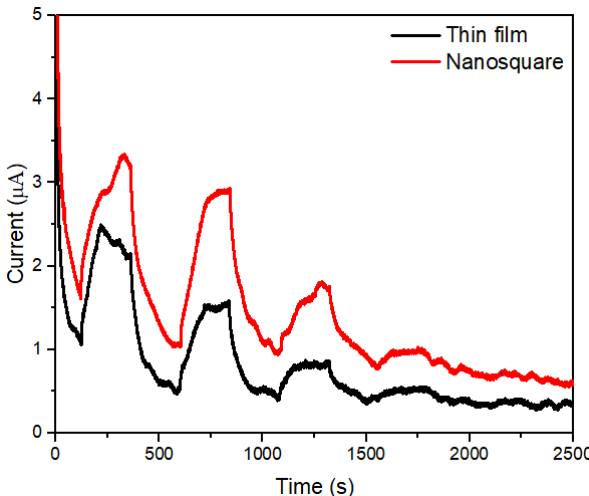
Figure 4. The stability curve of the ZnO/Au thin film and the ZnO/Au nanosquare arrays at scan rates between 0.12 V s -1 and 0.18 mM of glucose concentration under a 450 nm wavelength.